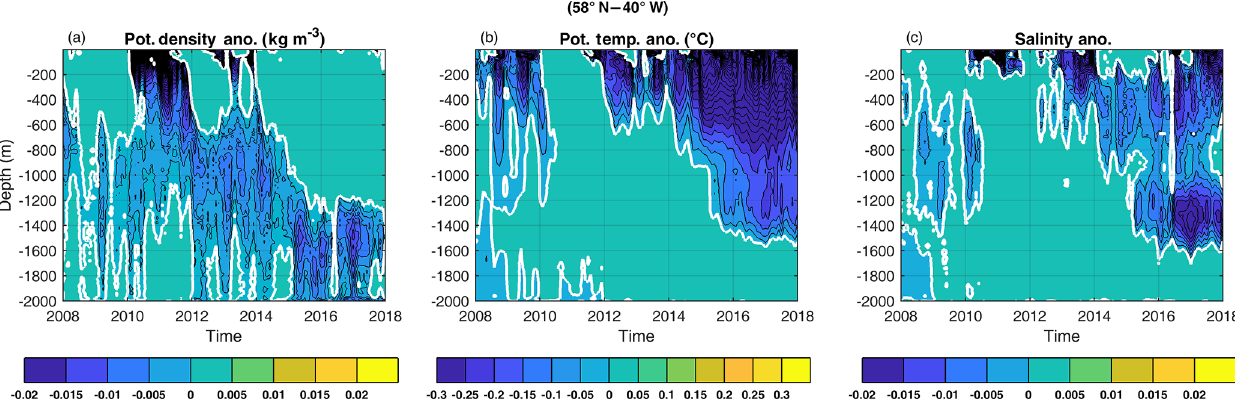
Figure 8. Evolution of vertical profiles of monthly anomalies of (a) σ 0 , (b) θ and (c) S at 58 ◦ N, 40 ◦ W. The anomalies were estimated from the ISAS database (Gaillard et al., 2016) and were referenced to the monthly mean estimated for